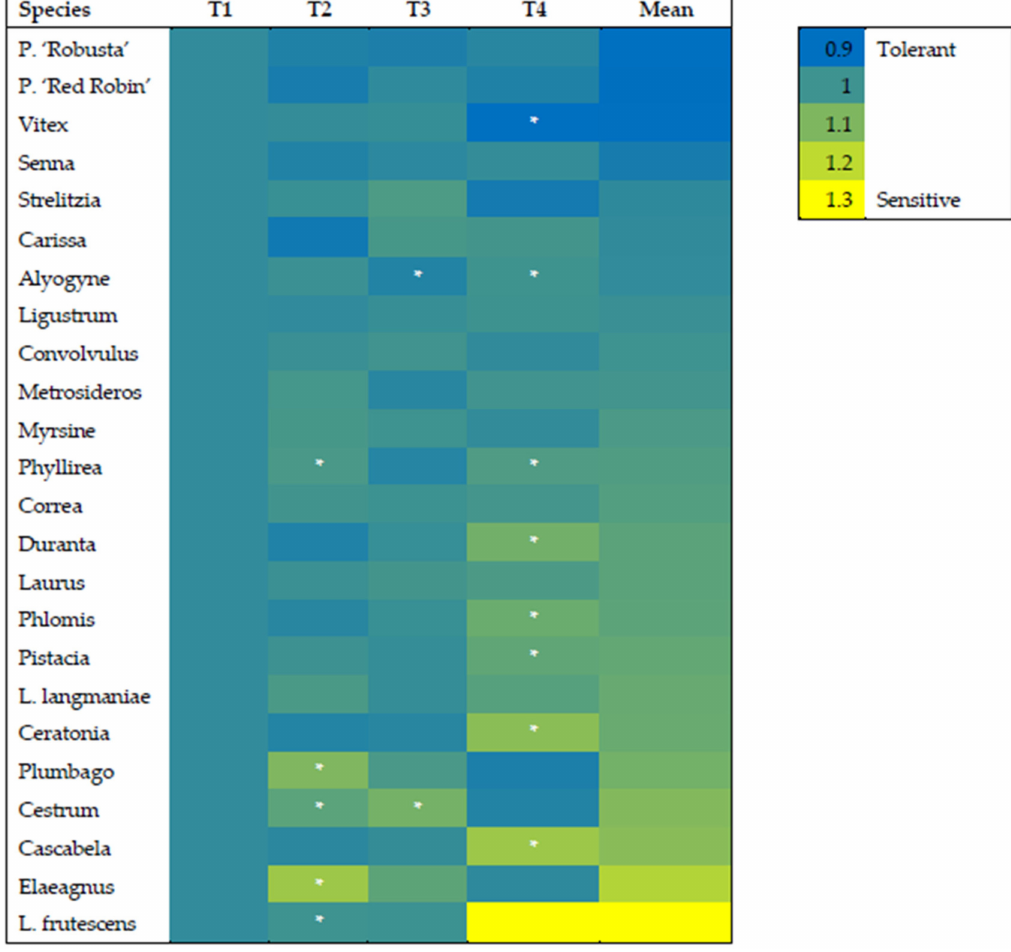
Figure 6. HeatMap of the maximum quantum e ffi ciency of photosystem II (Fv / Fm ratio) between control and treatment groups for twenty-four species of ornamental shrubs exposed to salt spray. Plants were subjected twice a week to nebulization treatment with simulated seawater solution for 60 days. At the beginning and every 20 days [T1 (0 days), T2 (20 days), T3 (40 days), T4 (60 days)] of